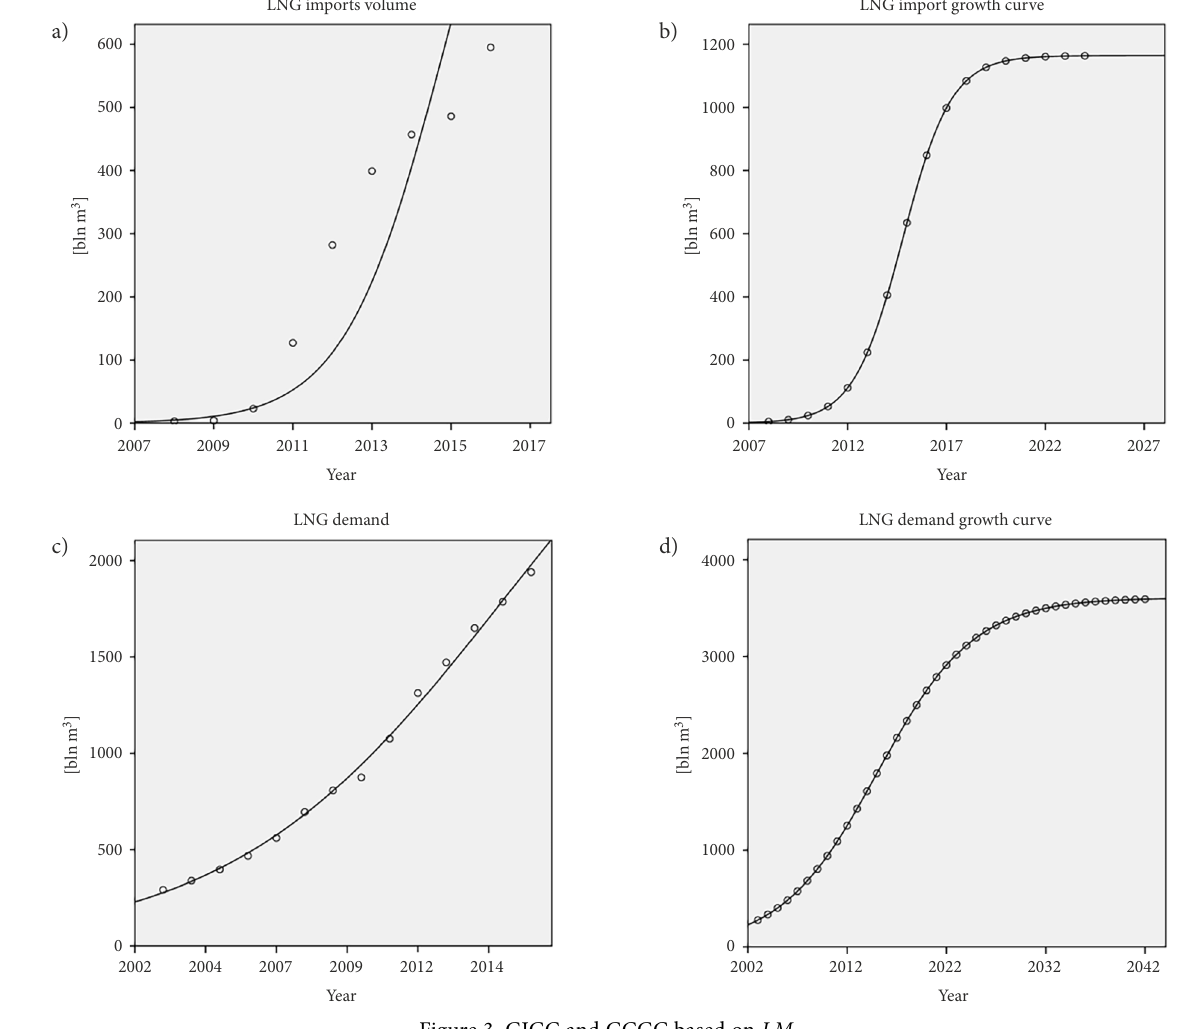
Figure 3. GIGC and GCGC based on LM 6 Table 4. The statistical data of the four growth curves based on LM 6 Formula of the